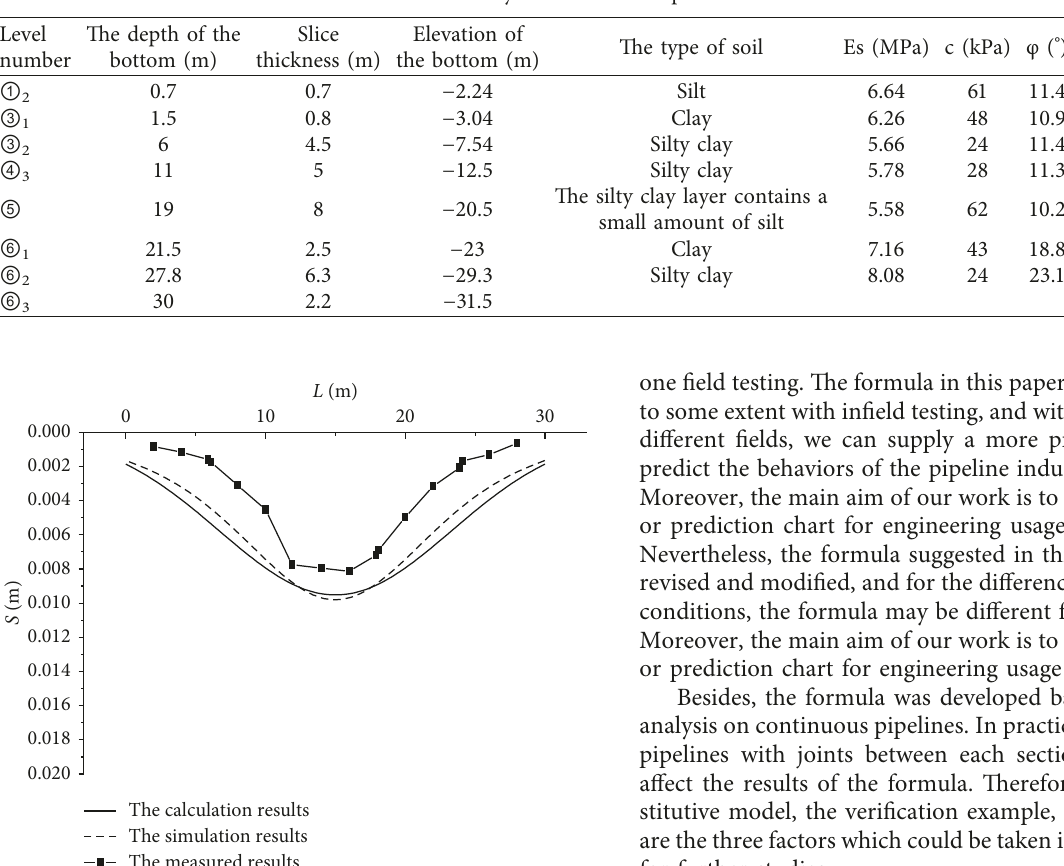
Figure 9: Spatial location of subway tunnel and Table 2: Physical-mechanical parameters of soil.